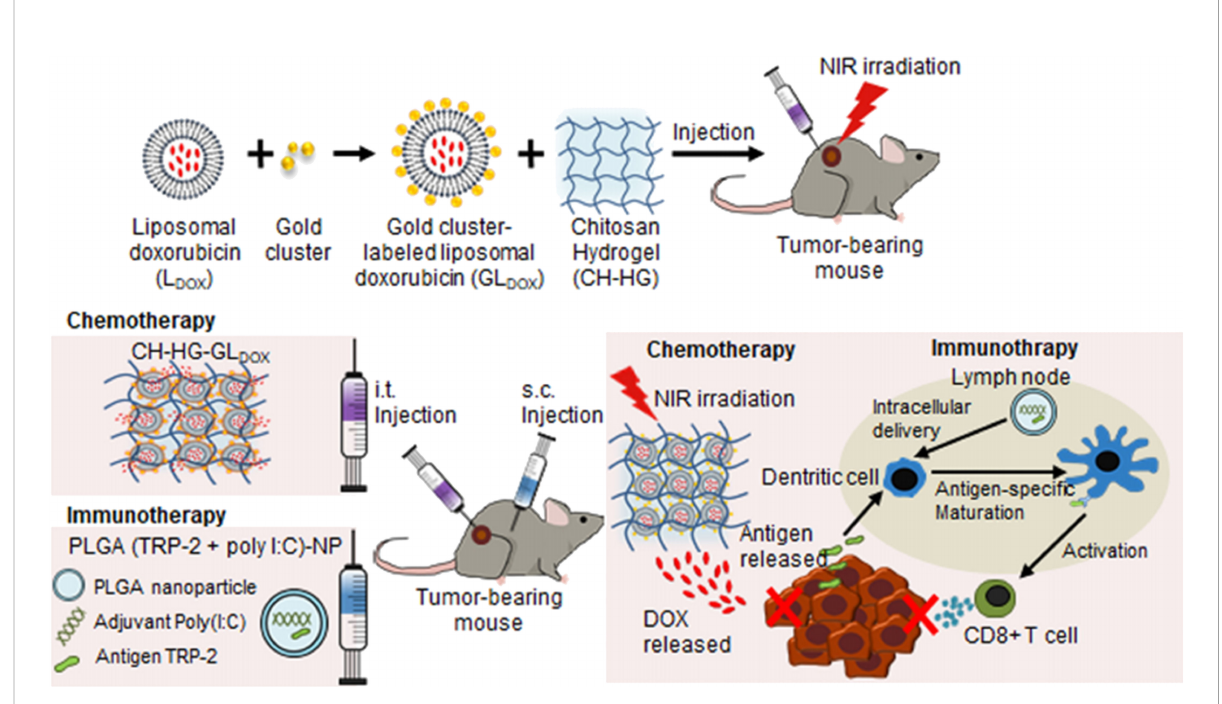
FIGURE 11 Local injectable chitosan serves as a drug depot to control tumor relapse. Intratumoral injectable chitosan nanoformulation for combined chemo- and immunotherapy of cancer. Reprinted with permission from (139), Copyright (2021)